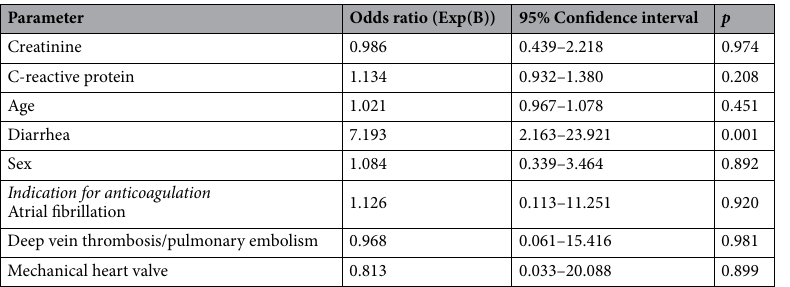
Table 2. Multinomial logistic regression analysis on patients with VKA using overanticoagulation as dependent binary variable. Creatinine, CRP and age were used as covariates, diarrhea, sex and indication for anticoagulation as factors. p < 0.05 was regarded statistically